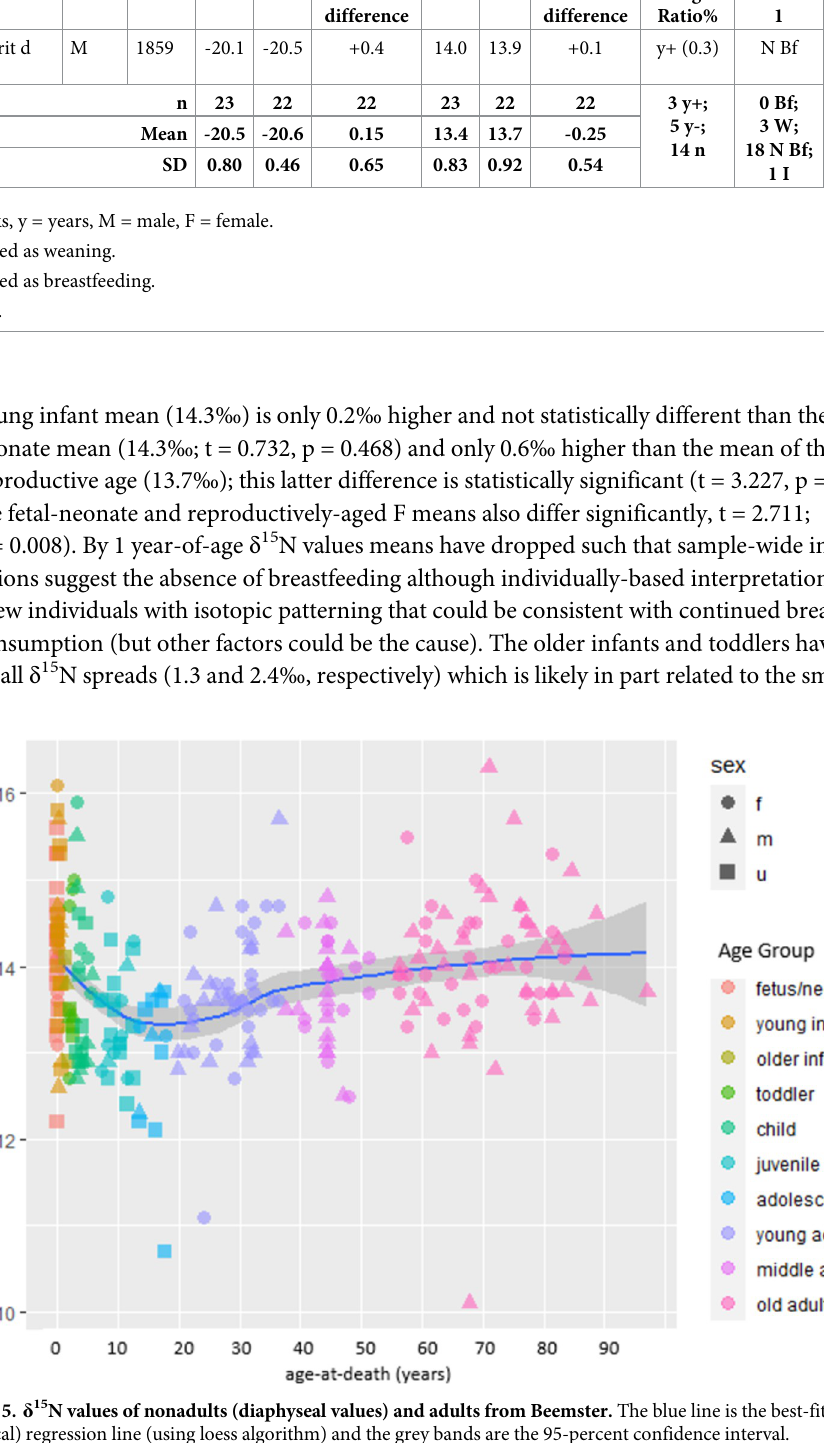
Fig 5. δ 15 N values of nonadults (diaphyseal values) and adults from Beemster. The blue line is the best-fit smoothed (local) regression line (using loess algorithm) and the grey bands are the 95-percent confidence interval.